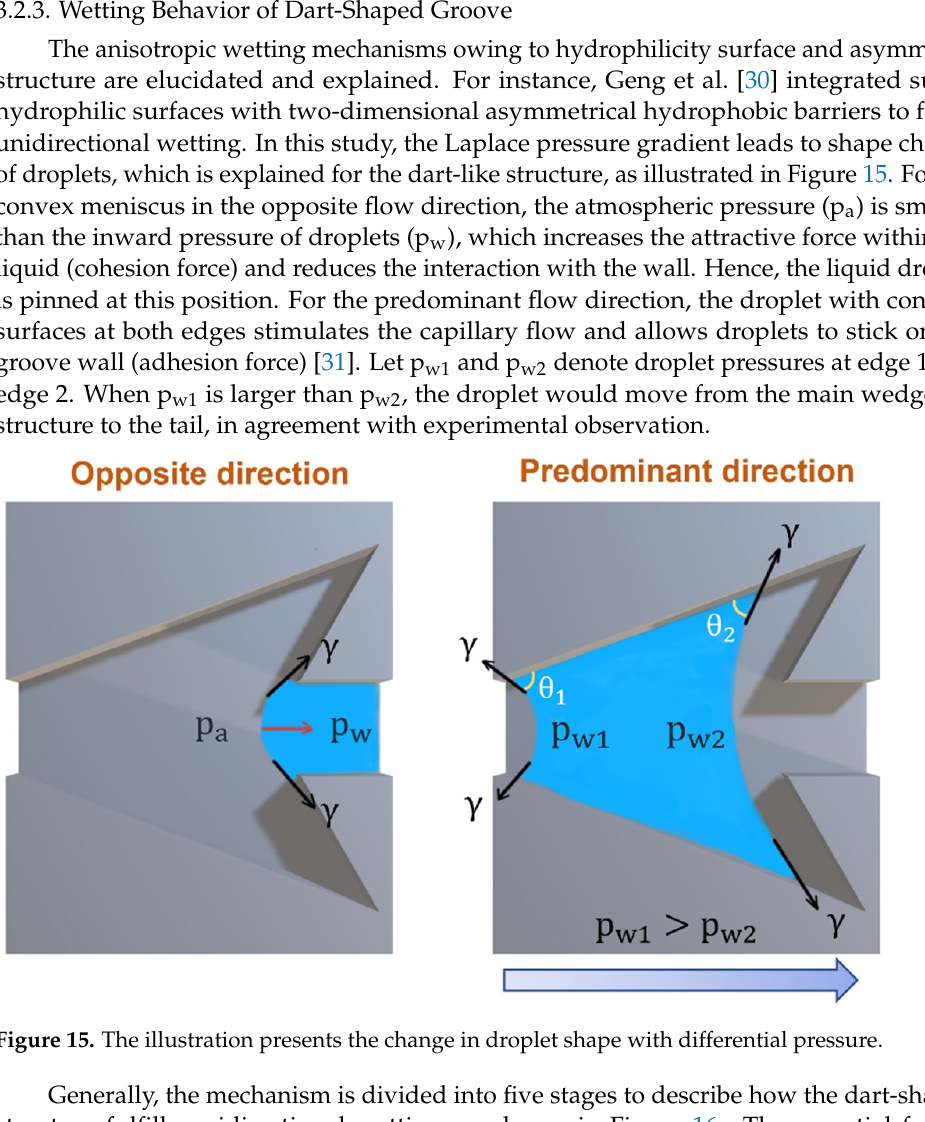
Figure 16. The illustration exhibits wetting mechanisms of dart-shaped structures for unidirectional wetting